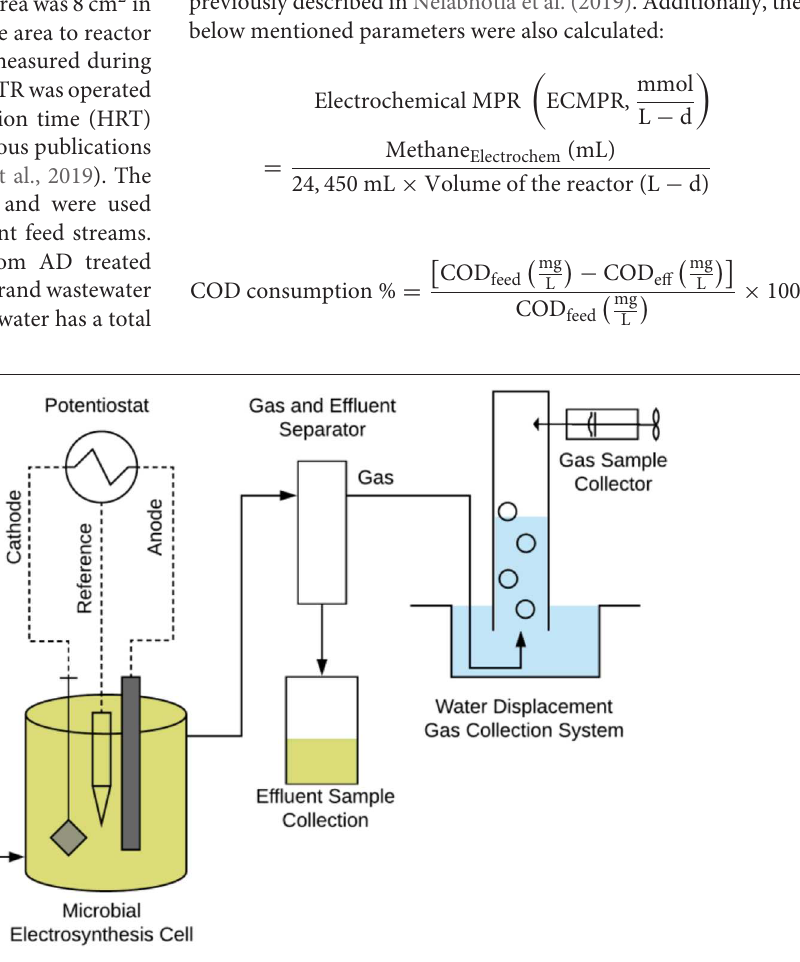
FIGURE 1 | Schematic diagram of the experimental